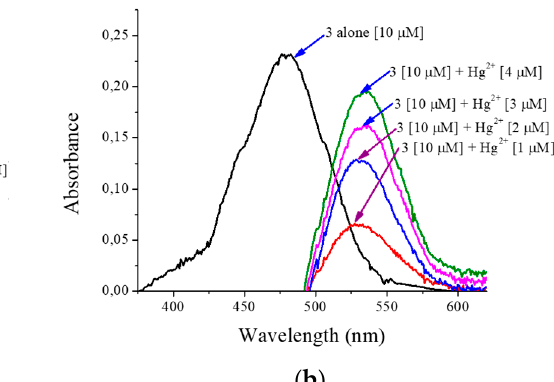
Cary ® 60; ( b ) the low-cost spectrophotometer in H 2 O:EtOH 80:20.